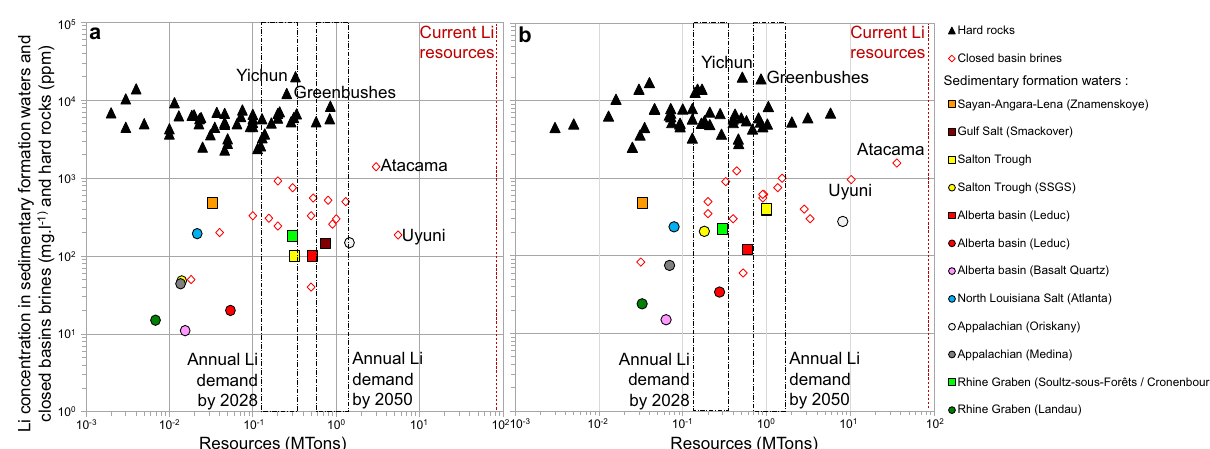
Figure 5. Lithium concentrations versus estimated lithium resources. The data used are reported in Tables 2 and 3 ( a ) data according to scenario 1 (this study) and lowest available resource estimates (published sources). ( b ) Data according to scenario 2 (this study) and highest available resource estimates (published sources). Hard- rock deposits (triangles); closed basin brines (diamonds); sedimentary formation waters from published sources (squares) 14,17,19–29 and this study